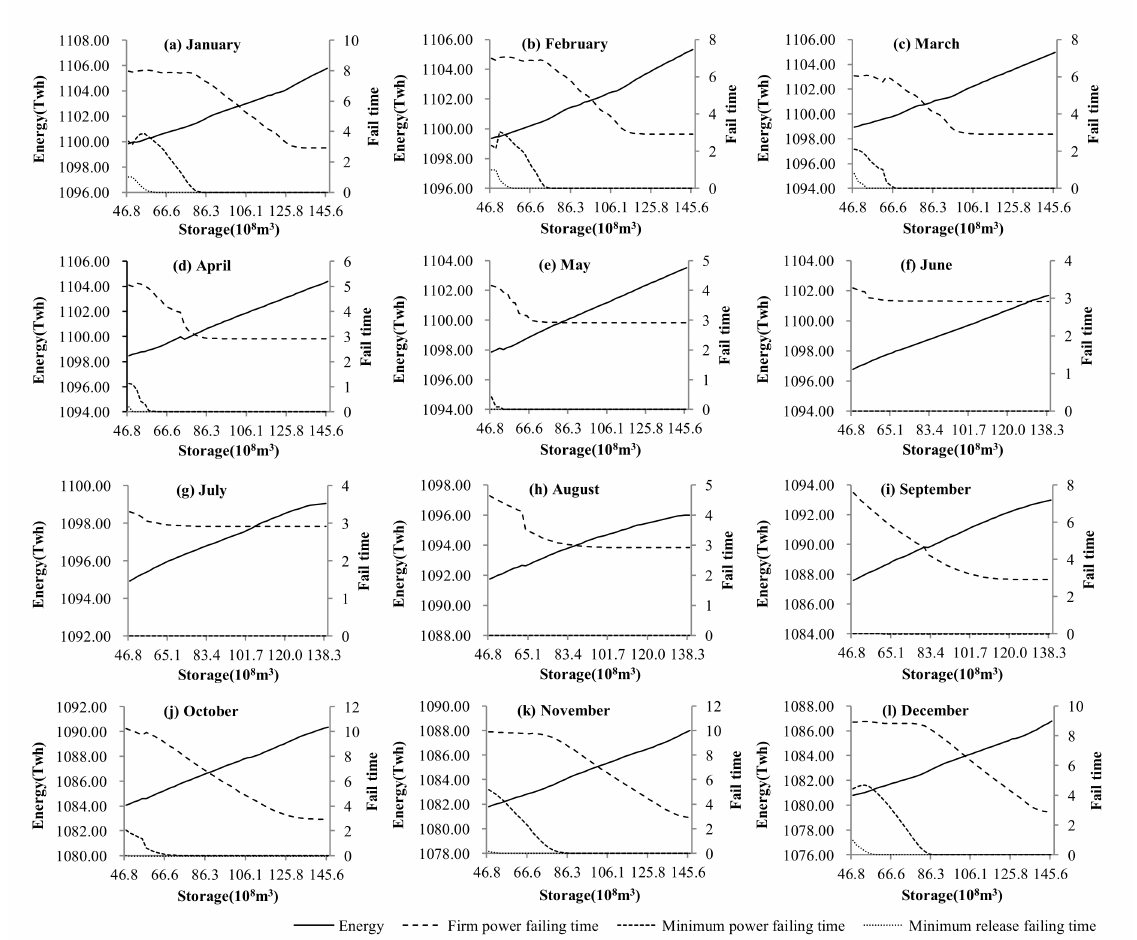
Figure 4. Failing chances and energy of independent inflow